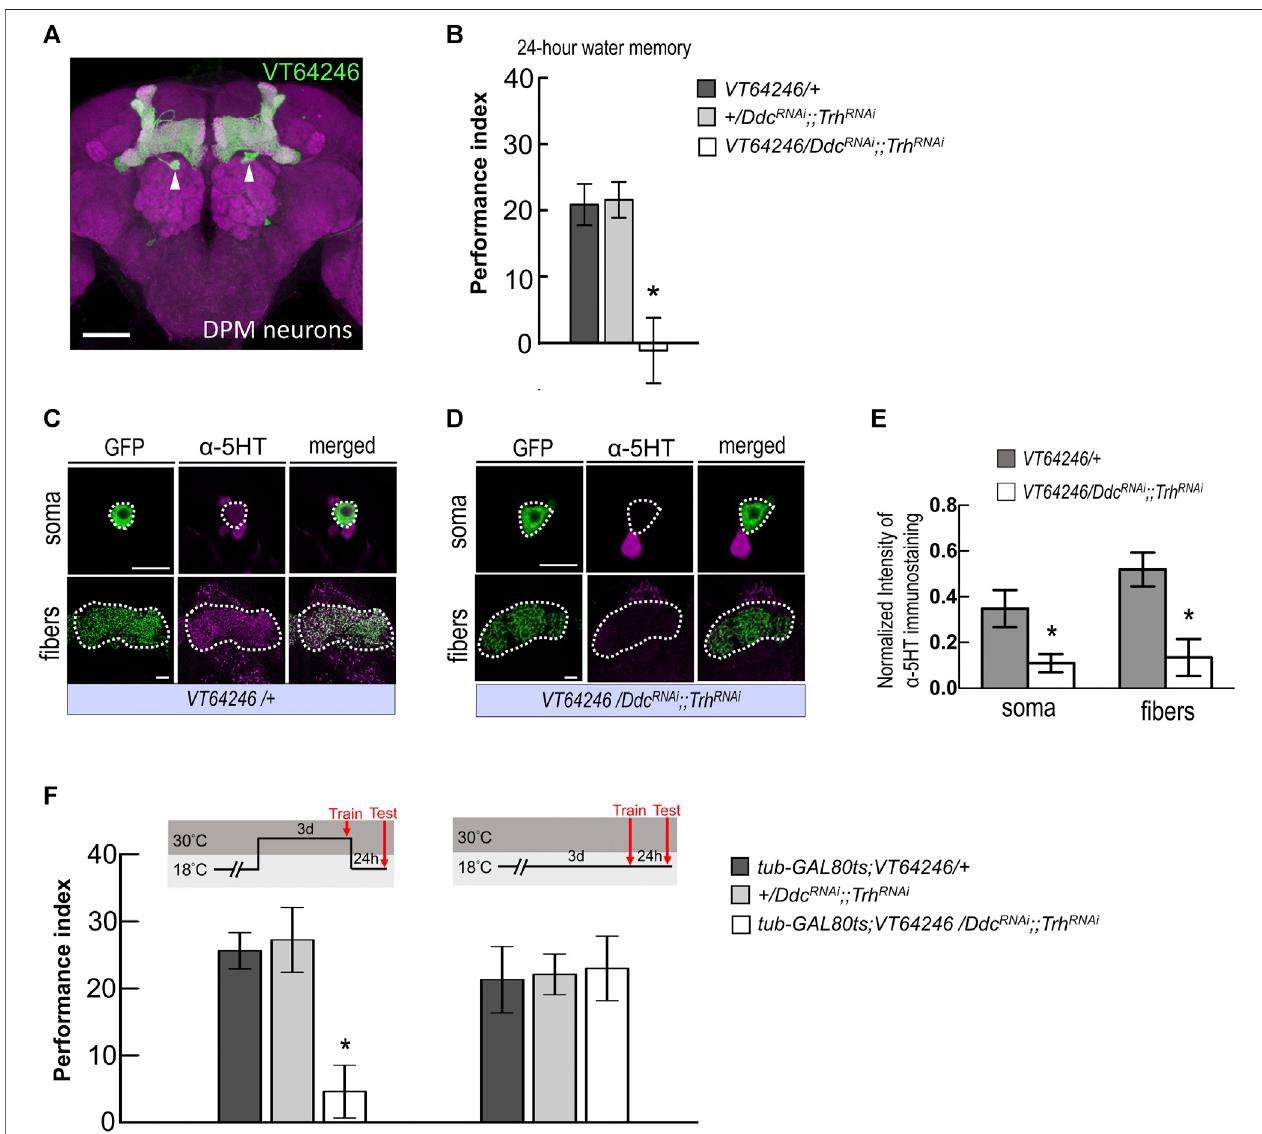
FIGURE 4 | Blocking serotonin biosynthesis in DPM neurons disrupted wLTM. (A) The expression pattern of VT64246-GAL4 (green). White arrowheads indicate the soma of DPM neurons. The brain was immunostained with anti-DLG antibody (magenta). Scale bar, 50 μ m. (B) Blocking 5HT biosynthesis in DPM neurons by expressing DDC RNAi and Trh RNAi disrupted the 24-h water memory. Each value represents mean ± SEM (N (cid:1) 8 for each bar). * p < 0.05; one-way ANOVA followed by Tukey ’ s test. (C) Immunostaining using anti-5HT antibody in DPM neurons and fi bers (magenta) in UAS-mCD8:GFP; VT64246-GAL4/+ fl ies. Scale bar, 10 μ m. Each valuerepresentsmean ± SEM(N (cid:1) 8and 7from lefttoright).* p < 0.05; t -test. (D) Immunostainingusinganti-5HT antibodyinDPMneuronsand fi bers (magenta) in UAS-mCD8:GFP; VT64246-GAL4 > UAS-Ddc RNAi ;;UAS-Trh RNAi fl ies. Scale bar, 10 μ m. (E) Quanti fi cation of 5HT immunostaining. Single optical section of DPM soma andDPM fi berswereanalyzedunderthesamerecordingcondition.The5HTstainingintensitywasnormalizedtotheGFPsignal.Eachvaluerepresentsmean ± SEM(N (cid:1) 8, 7, 8, 7 form left to right bars). * p < 0.05; t -test. (F) Adult-stage-speci fi c knockdown of 5HT biosynthesis in DPM neurons disrupted wLTM (left panel). Each value represents mean ± SEM (N (cid:1) 8 for each bar). * p < 0.05; one-way ANOVA followed by Tukey ’ s test. Genetically modi fi ed fl ies showed normal wLTM when kept at 18 ° C (right panel). Each value represents mean ± SEM (N (cid:1) 10 for each bar). * p < 0.05; one-way ANOVA.